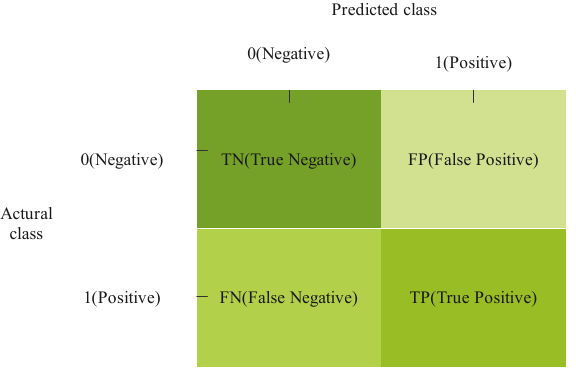
Figure 5. Confusion